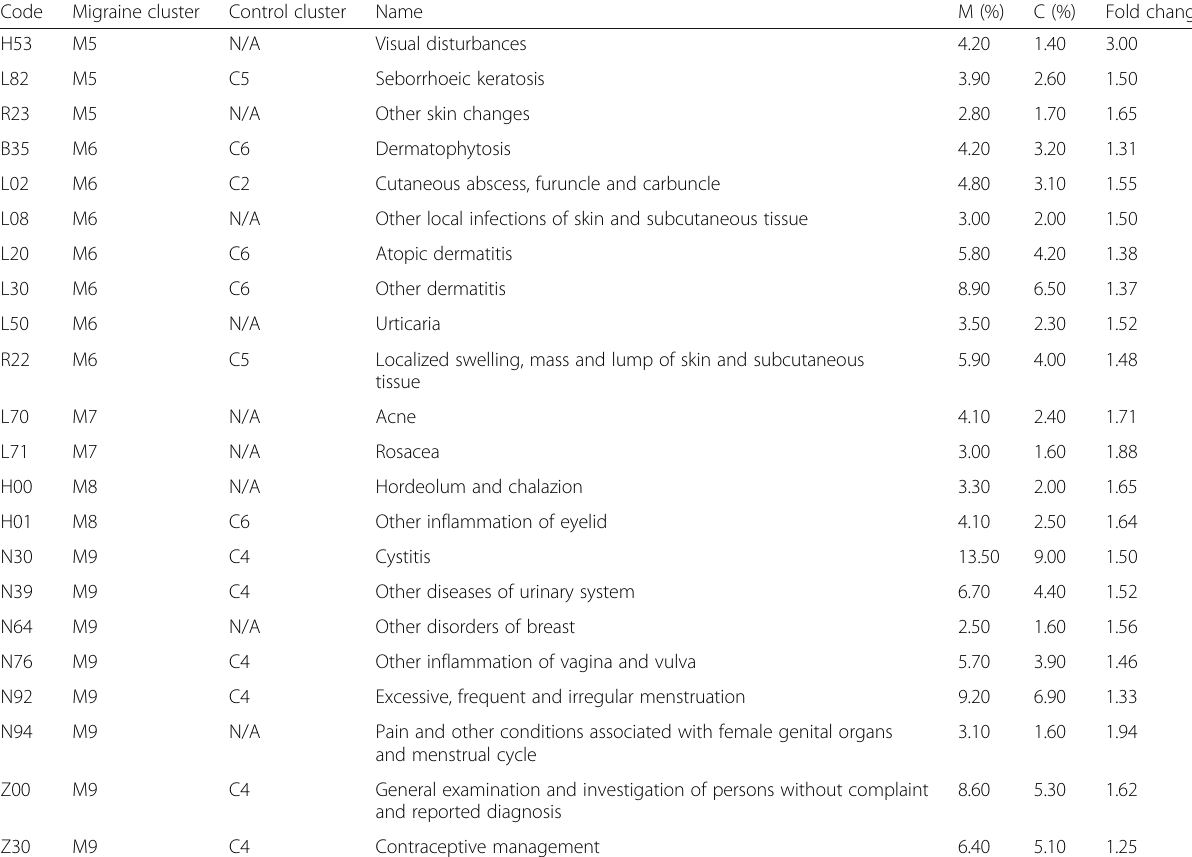
Table 2 List of diagnosis clusters from Fig. 2 sorted by their presence in migraine patients (2.5 – 20% prevalence) and compared to controls. Fold change column shows the prevalence in migraineurs divided by the prevalence in controls. All fold changes are greater than 1 indicating that migraine is associated with higher multimorbidity compared to controls. Due to high sample size, the difference in prevalence between migraineurs and controls is statistically significant ( p < 0.001) for each diagnosis